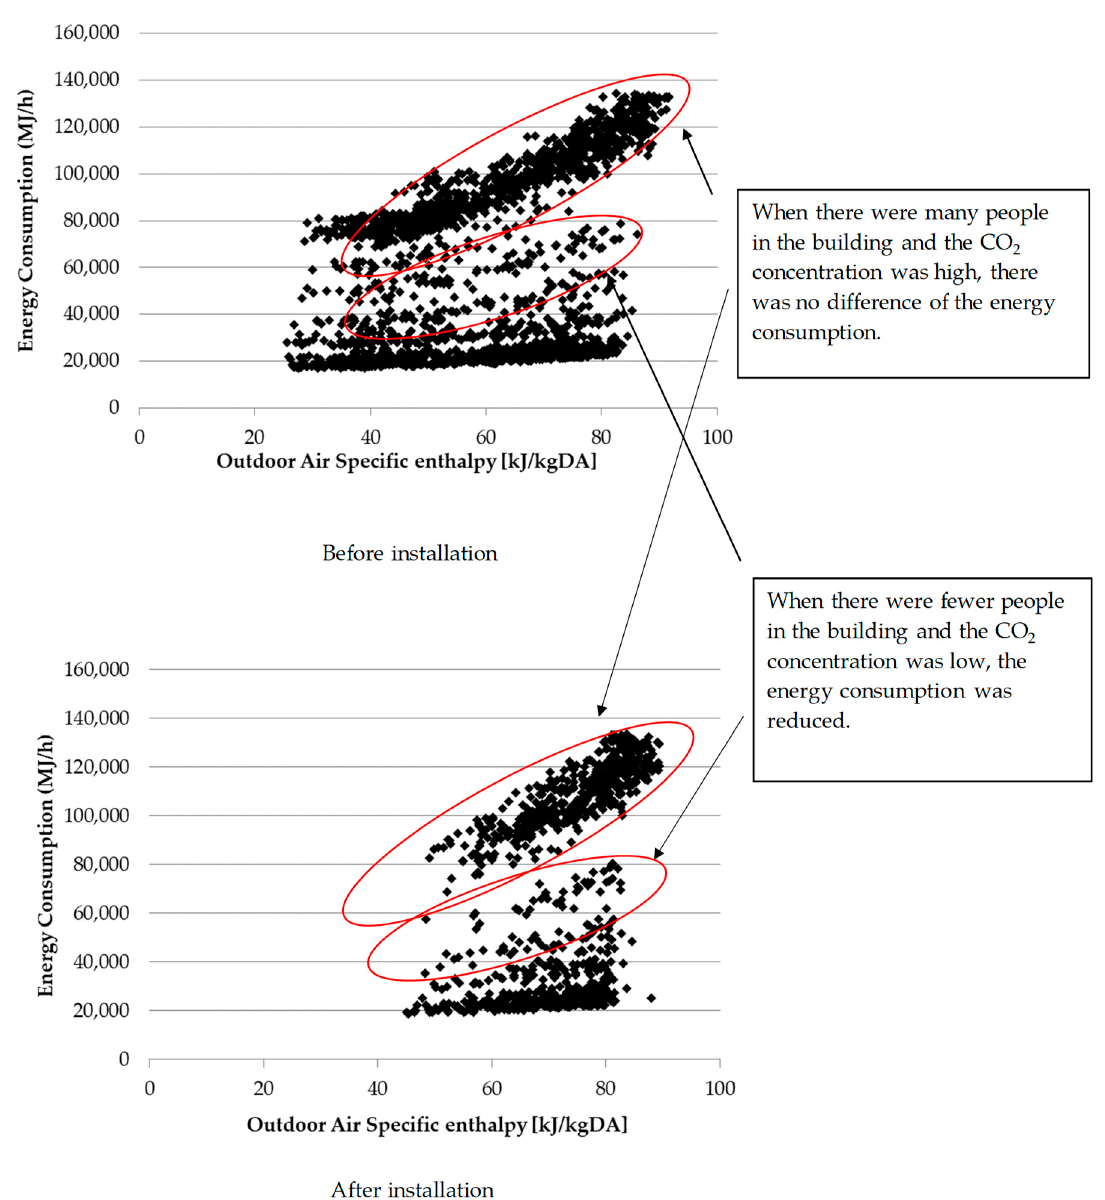
Figure 7. Correlation diagrams between outside-air specific enthalpy and total energy for outside-air processing.